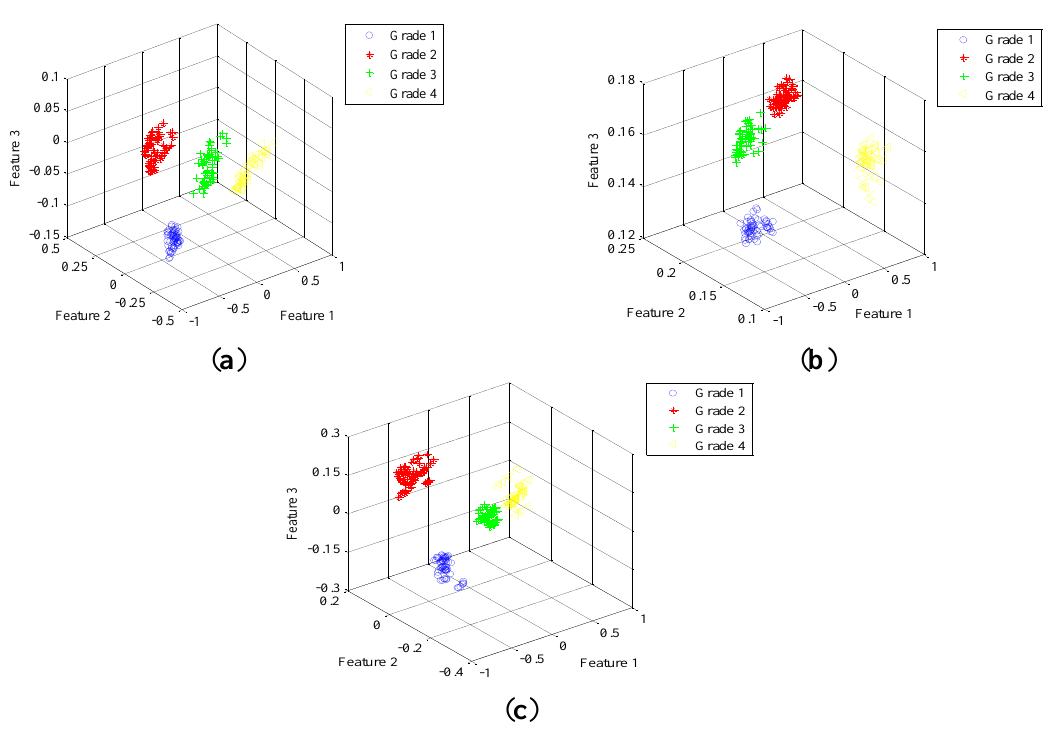
Figure 15. Distributions of three-dimensional fused features. ( a ) RH = 80%; ( b ) RH = 85%; ( c ) RH =